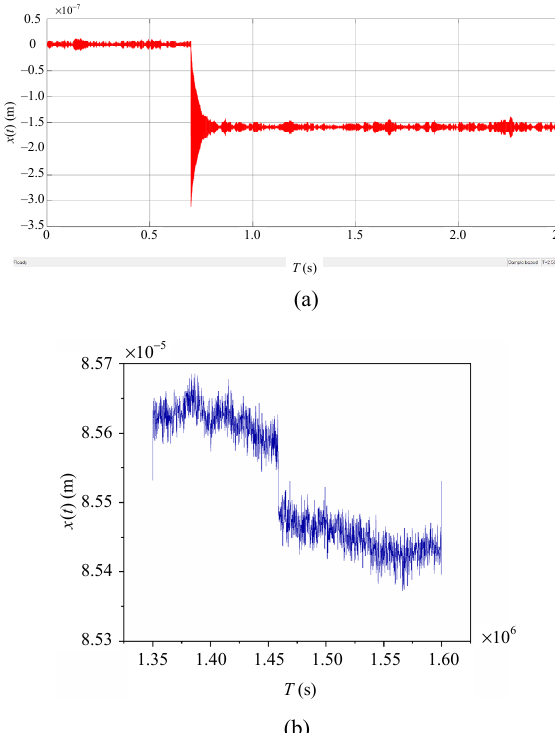
Fig. 6 “Step” generated by applying the step Coulomb force: (a) simulation and (b) experimental results.